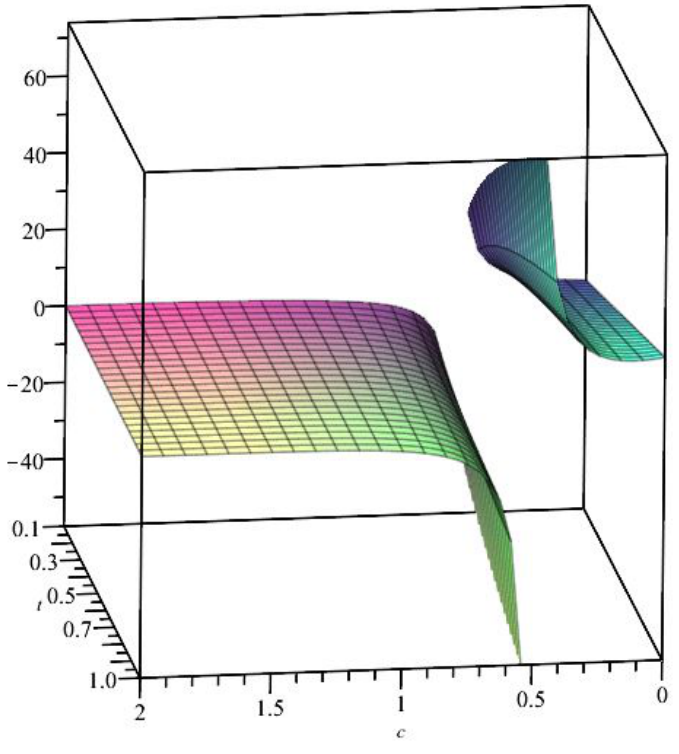
Figure 5. The variation of U { c } w.r.t. c and θ 2 : = t